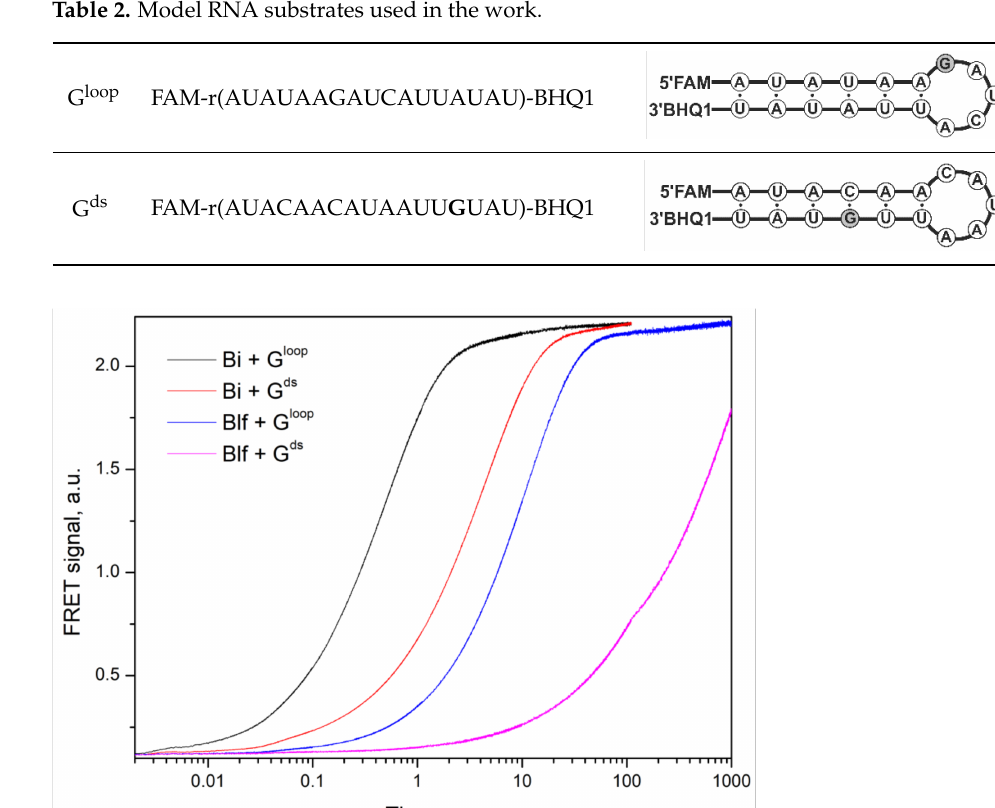
Table 2. Model RNA substrates used in the work.